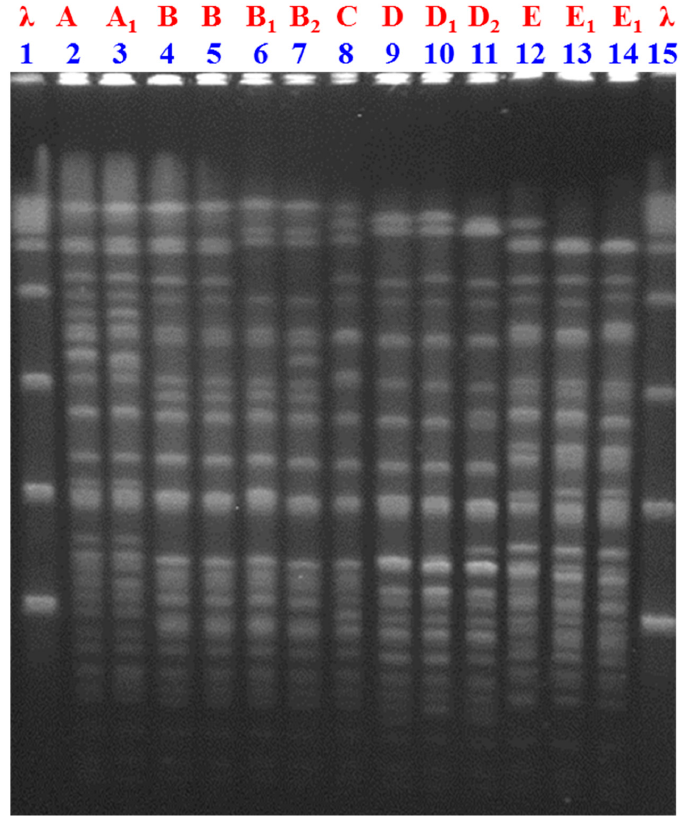
Figure 1. ApaI pulse-field gel electrophoresis (PFGE) patterns of A baumannii . Lanes 1, 15 contain molecular size patterns (lambda ladder). Lanes 2,3 (PFGE pattern A), 4–7 (B), 8 (C), 9–11 (D) and 12–14 (E). Isolates with more than 3 fragment variations were assumed to represent strains with major patterns (assignment of capital letters), while isolates with 1–3 fragment differences were considered subtypes (capital letters with numerical